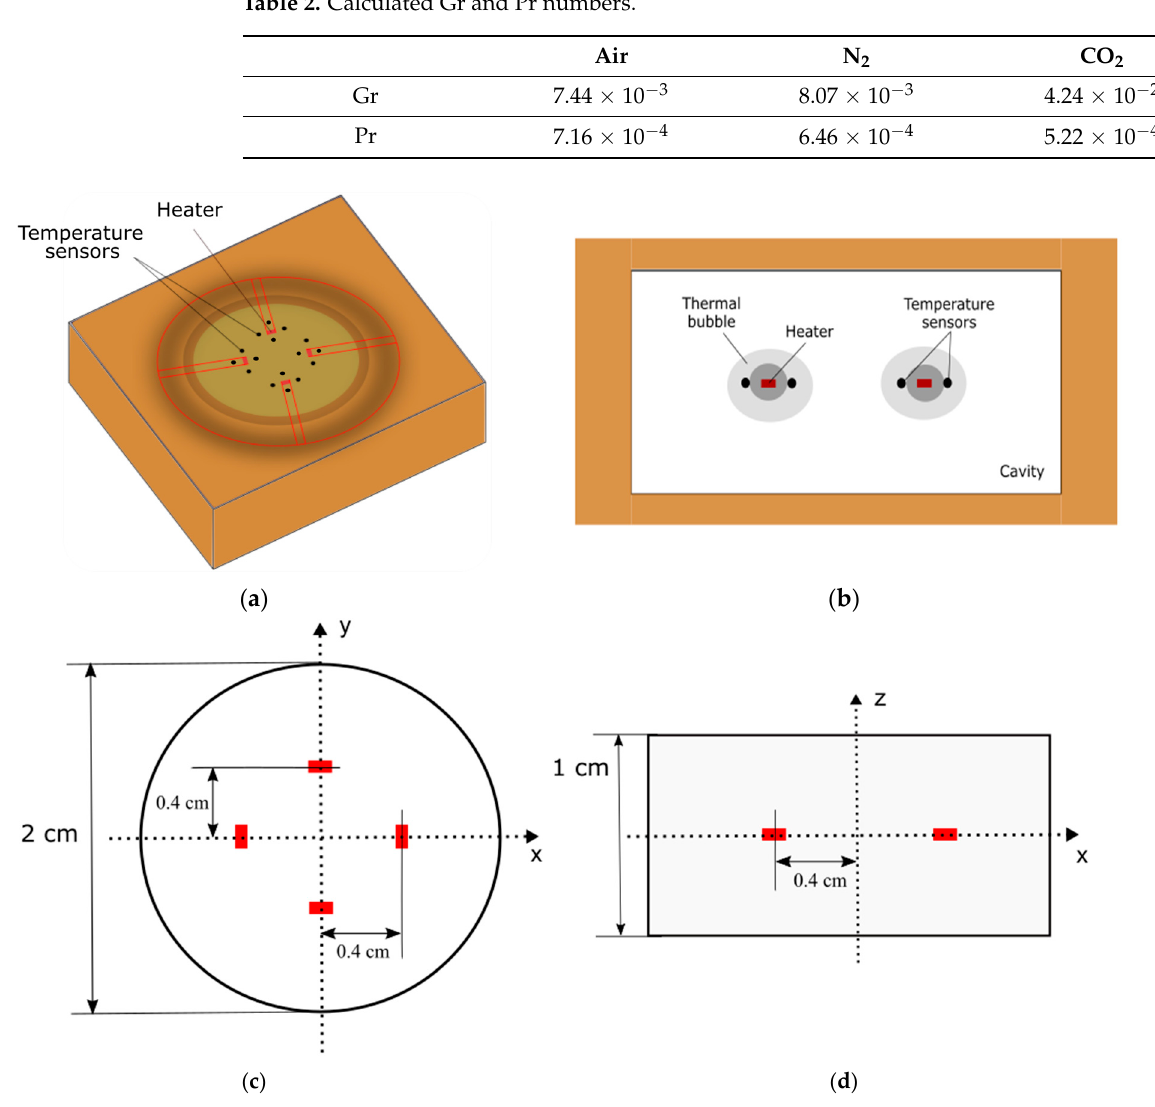
Figure 3. Model illustration: ( a ) isometric view; ( b ) side view and geometric dimensions: ( c ) cross- section view; ( d ) side view. Table 1. Gas medium properties at 50 °C (adapted from [8]).